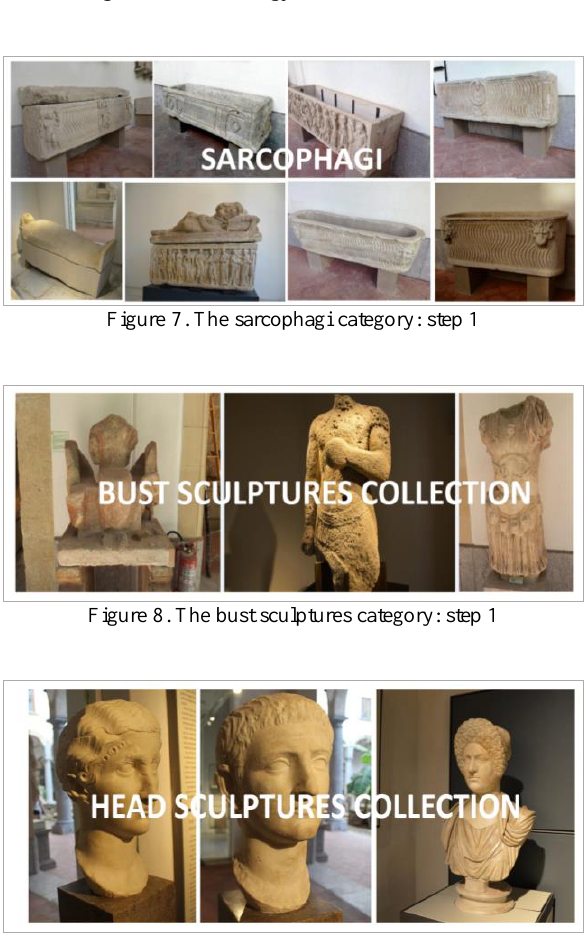
Figure 9. The head sculptures category: step 1